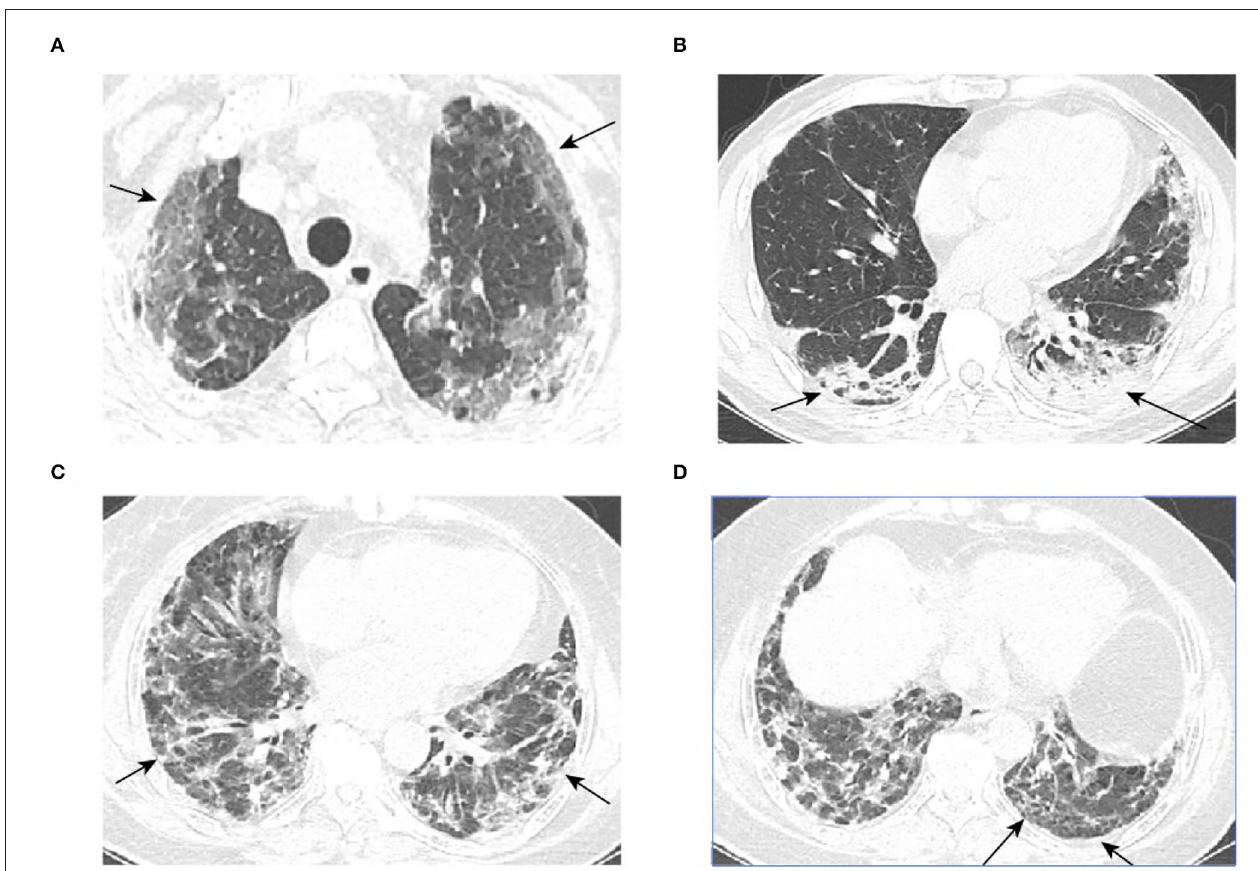
FIGURE 1 | Representative CT images. (A–D) are typical GGO, consolidation, reticular, and honeycomb images, respectively (red arrows).